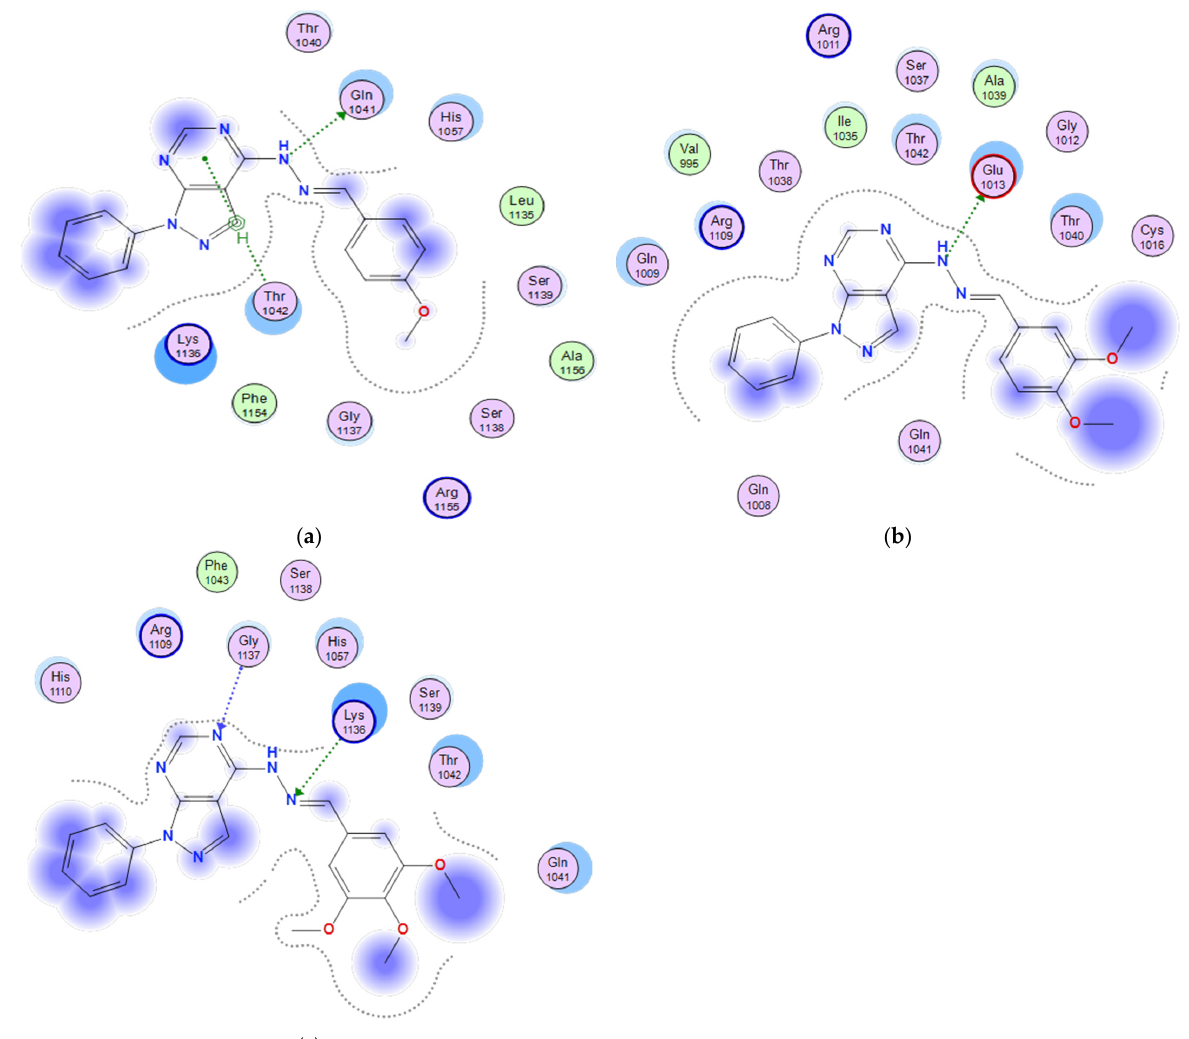
Figure 8. Two-dimensional binding mode of the test compounds ( a ) 6 , ( b ) 5 , and ( c ) 7 in the binding site of P21 protein (PDB ID: 6nzv) using MOE software.